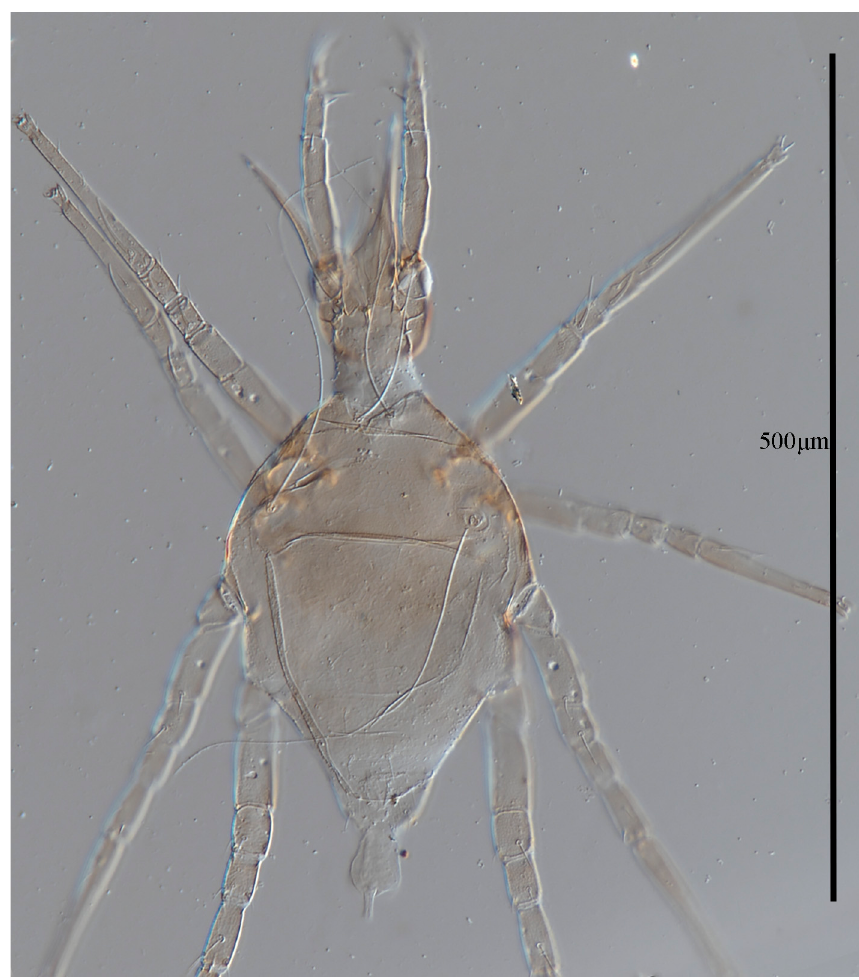
Figure 14. Brevicaudus trapezoides sp. nov . (male). Entire specimen (photo). Scale bar = 500 µm.